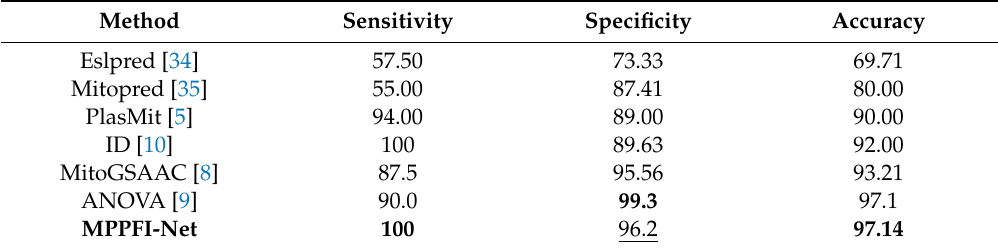
Table 4. MPPIF-NET comparative analysis with other models on PF175